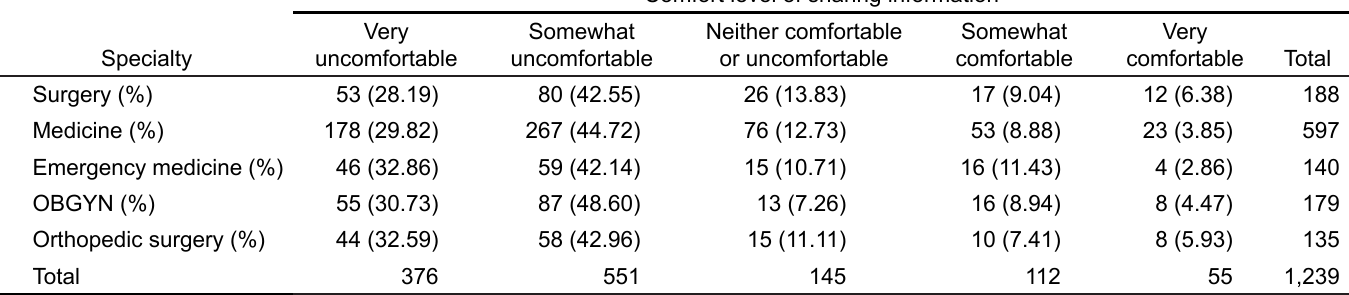
OBGYN , obstetrics and